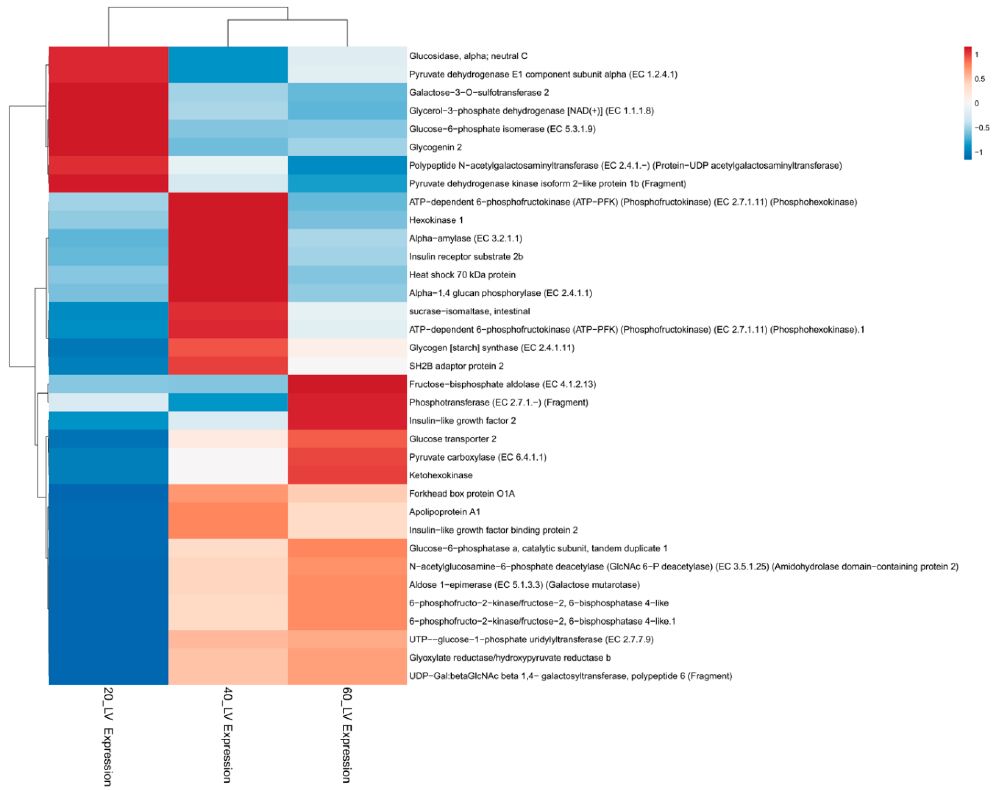
Figure 10. Heat map for hierarchical clustering of differential gene expression for selected genes. Fish feed 20% CHO was used as the control, and we also used 40% CHO and 60% CHO. Different colors indicate different P ‐ value ( − 1 to 1). indicate di ff erent P -value ( − 1 to